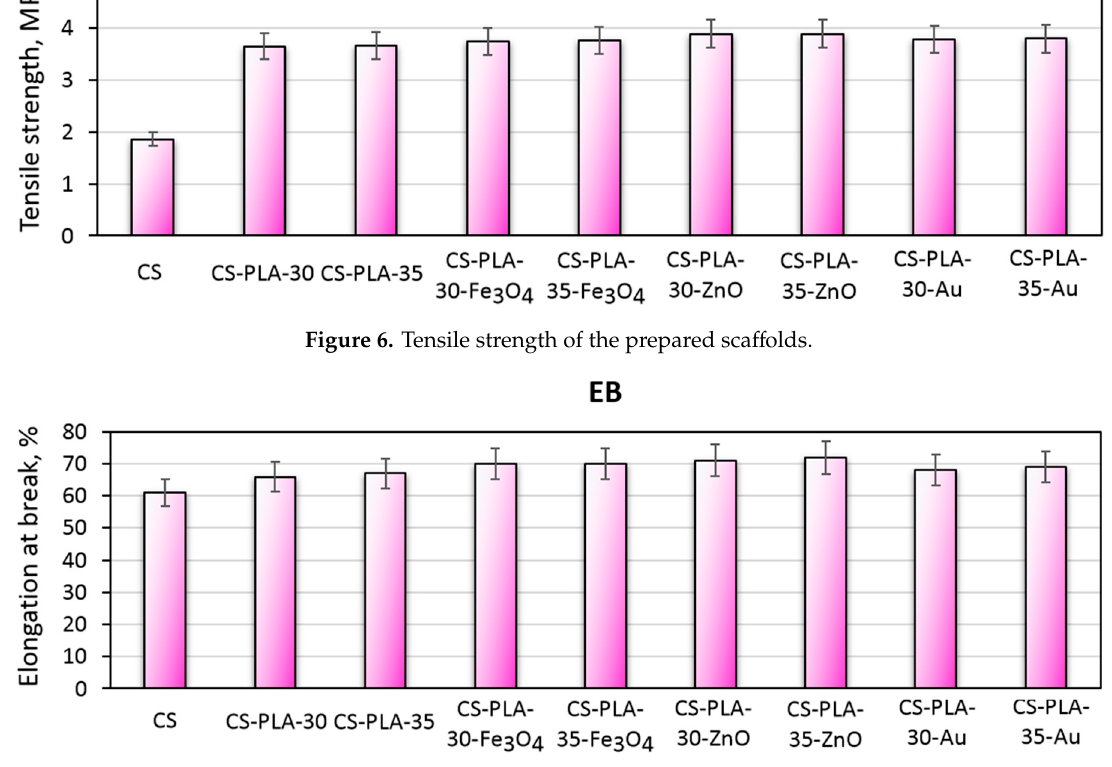
Figure 7. Elongation at break of the prepared scaffolds.